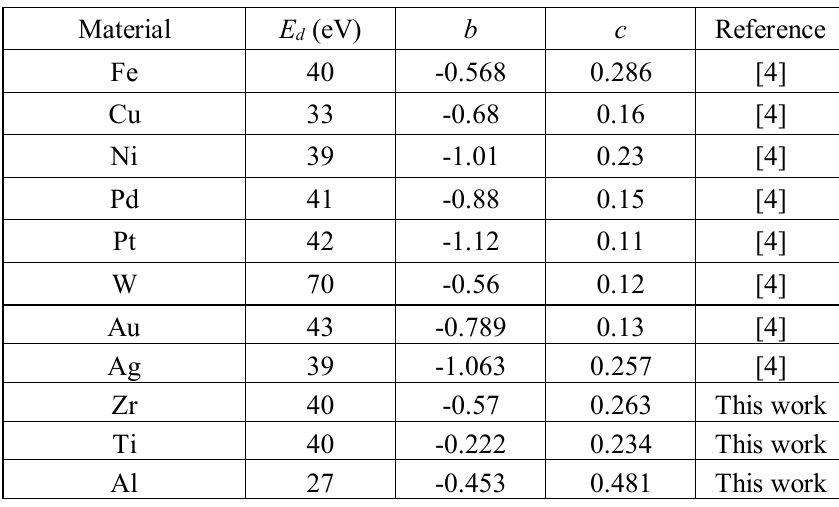
vs E for Zr, Ti and F p